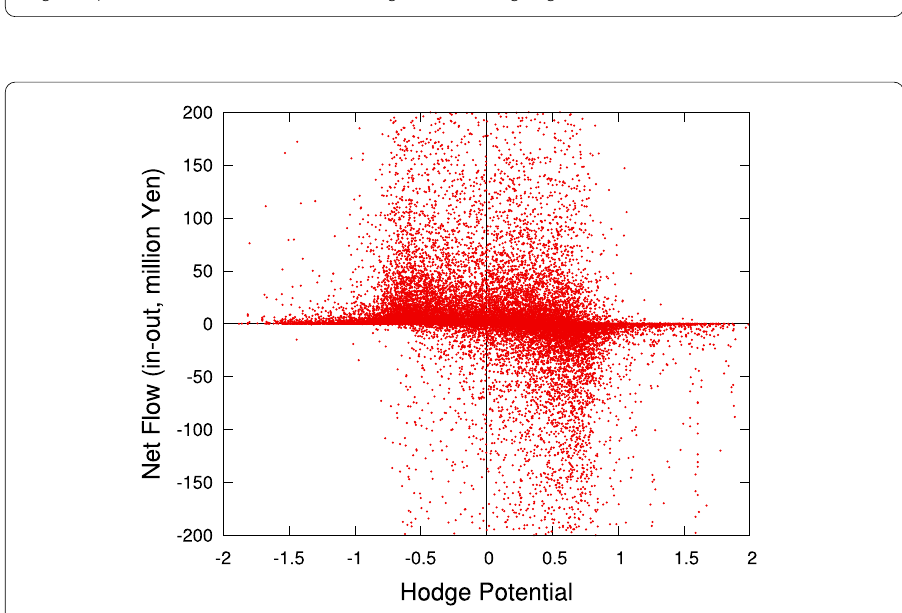
Figure 10 Hodge potential and net flow for each node. This figure is similar to Fig. 9 except for the vertical axis, which represents the net flow. The net flow is defined by the difference between the incoming